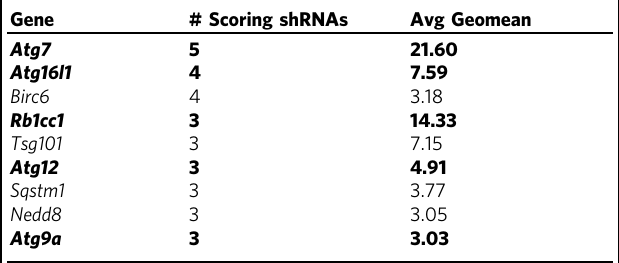
Table 1 shRNA-based screen identi fi es nine positive autophagy regulators using restrictive analysis criteria Gene # Scoring